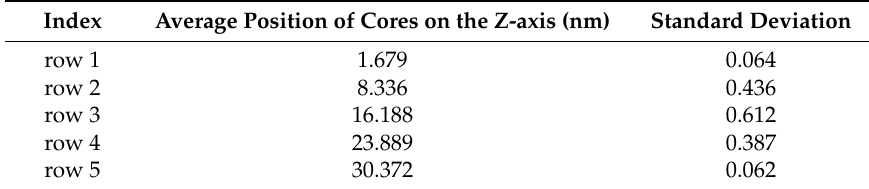
Figure 8. Density distributions of B beads in the radial direction under YW55 confinement at successive simulation time. The three dotted lines with increased widths correspond to the density at 399.2 × 10 3 steps, 399.4 × 10 3 steps and 399.6 × 10 3 steps, and the two solid lines with increased widths correspond to the density at 399.8 × 10 3 steps and 400 × 10 3 steps. The density distributions of five individual cylinders from row 1 to row 5 are colored in black, red, blue, magenta and dark green, respectively. Table 3. The position statistics of the five cores originating from Figure